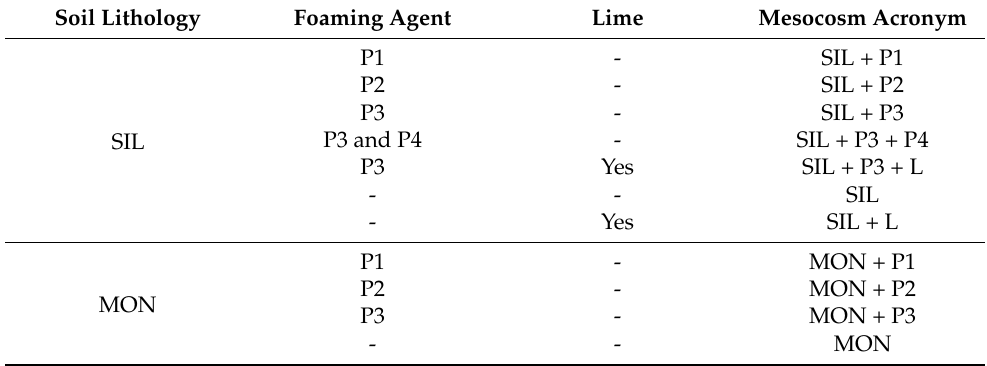
Table 2. Summary of the 11 experimental conditions (soil mesocosms) at the construction site. Soil Lithology Foaming Agent Lime Mesocosm